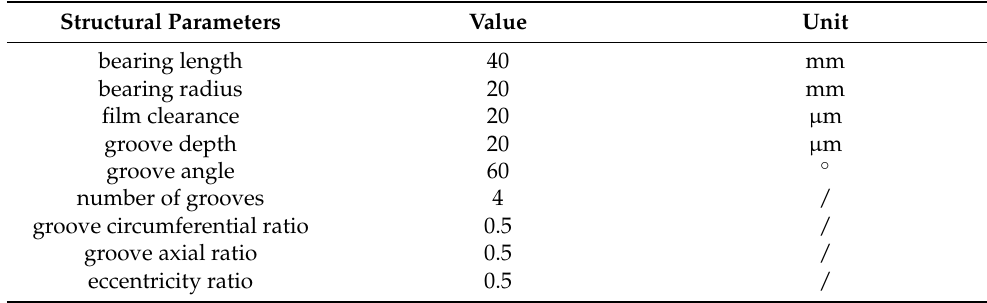
Figure 1. Schematic diagram of herringbone grooved journal bearing. ( a ) Three-dimensional structure; ( b ) expanded view; ( c ) cylindrical coordinate system. Table 1. Structural parameters of herringbone grooved journal bearing.